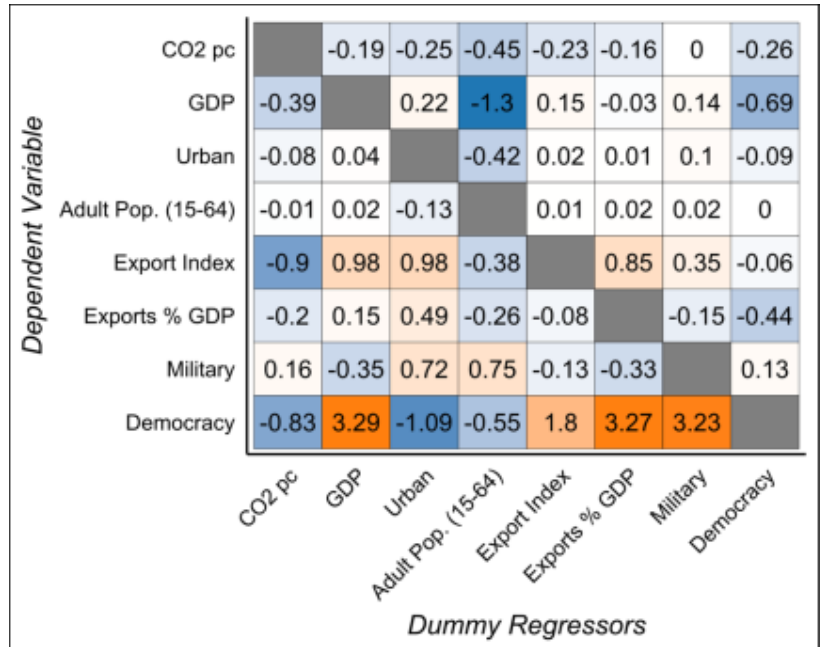
Figure 2. Missing Variable